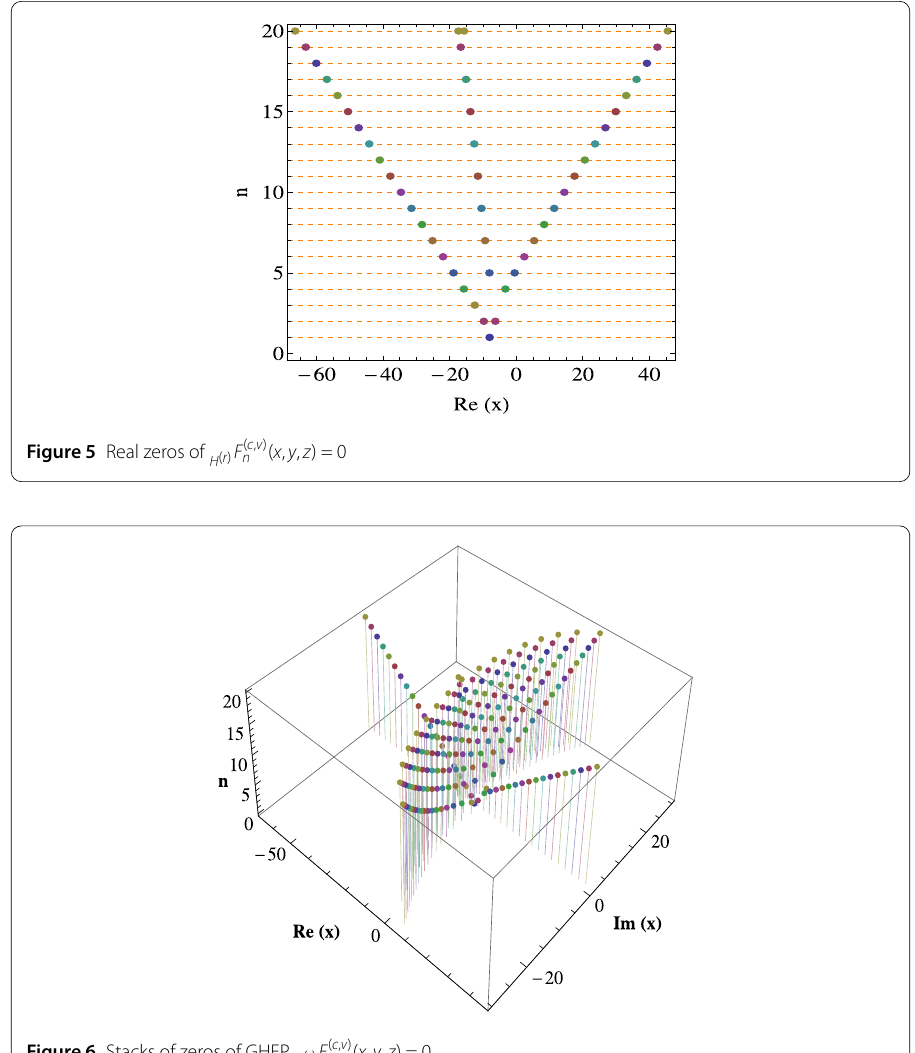
F ( c , v ) n ( x , y , z ) = H ( r )